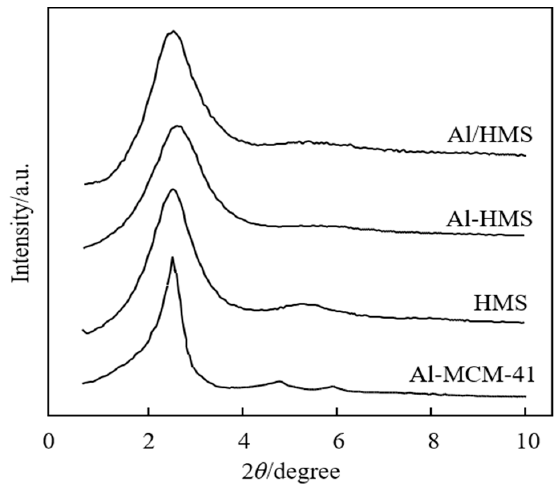
Figure 1. X-ray diffraction (XRD) patterns of mesoporous silica samples after calcining at 550 ◦ C for 4 h.